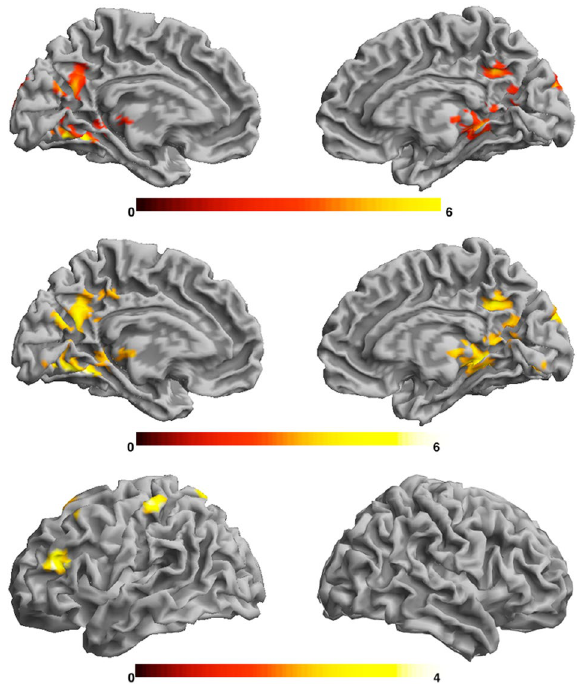
Figure 3. Statistical parametric map showing the time x condition interaction (top), the confirmatory t-test results of temporal differences in brain activation (mid-adolescence > late-adolescence) in the MSIT activation effect (middle) and negative association between MSIT activation effect in mid-adolescence and maternal positive behaviour in early-adolescence (bottom). Colour bars represent standardized Z-scores. Right hemispheres are shown on the right. Results are corrected for multiple comparisons ( p < .05; see “Methods” for more details).